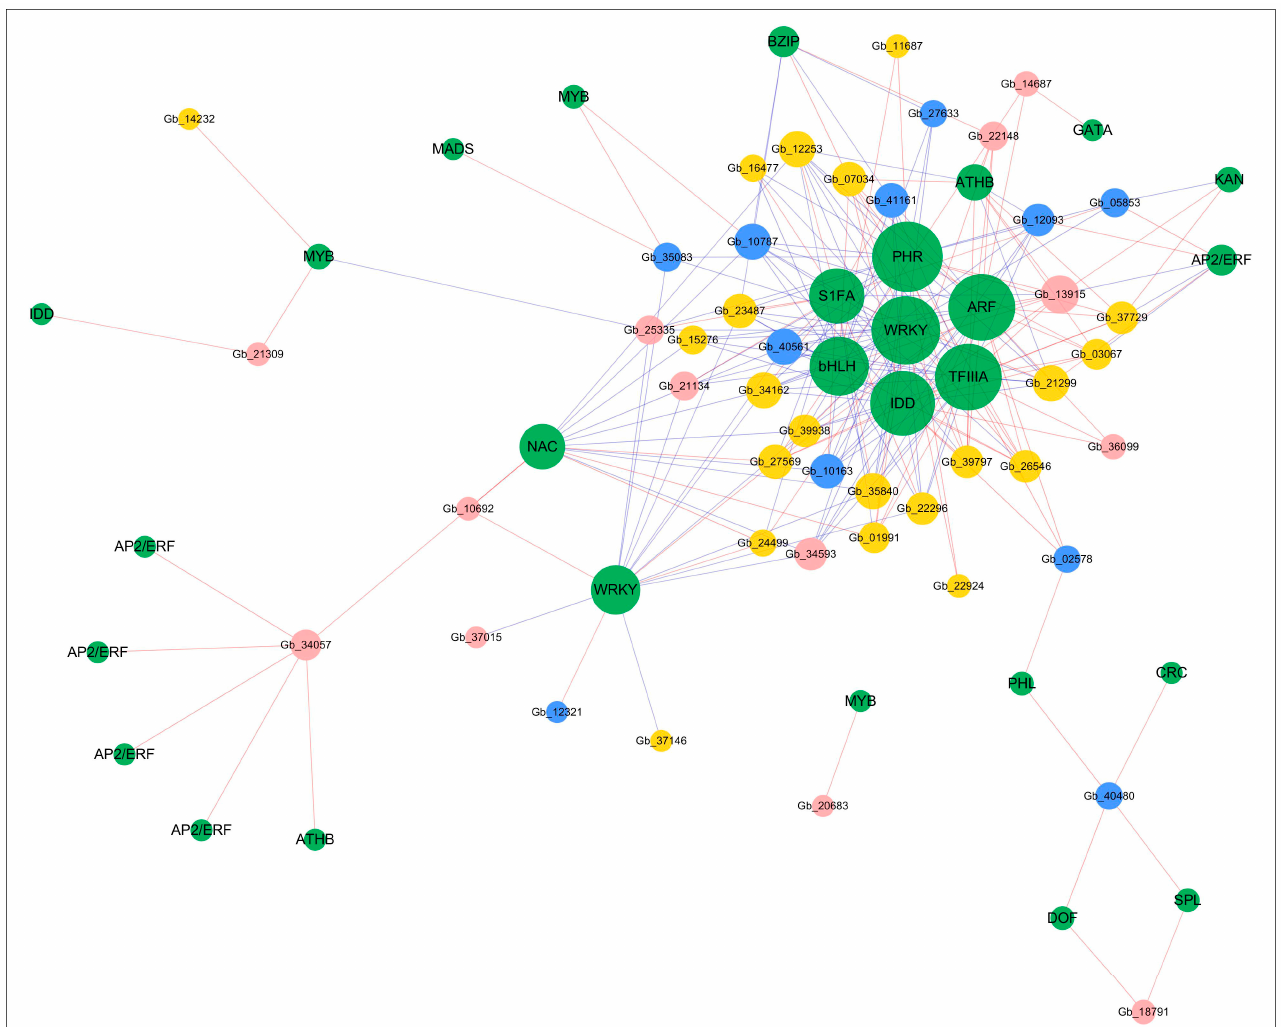
Figure 6. Co-expression network between TFs (green circles) and photosynthetic genes. According to genes function, the photosynthetic genes were grouped into three categories: membrane-based photosystem components (blue circles), electron transport genes (red circles), and photosynthesis regulating genes (yellow circles) (circle size is positively correlated with the connectivity of genes in the regulatory network and the red and blue lines indicate positive and negative correlations between genes ( p < 0.05, |r| > 0.8)).